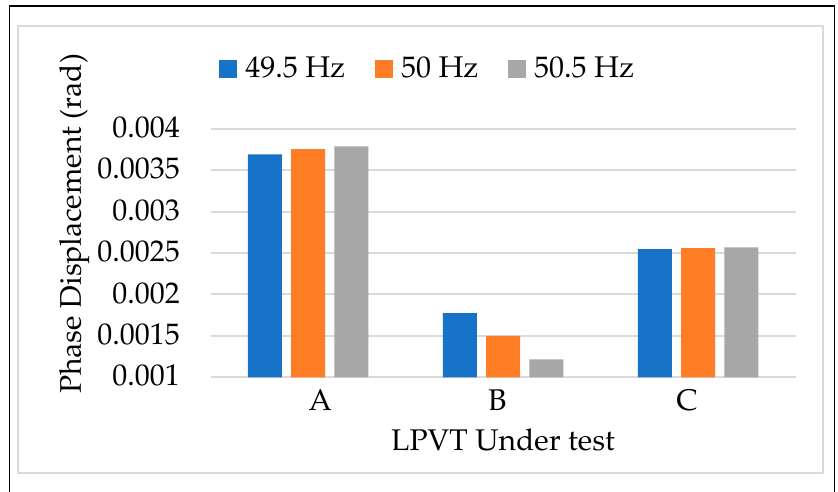
Figure 6. Phase displacement vs. frequency for the three LPVTs under test.